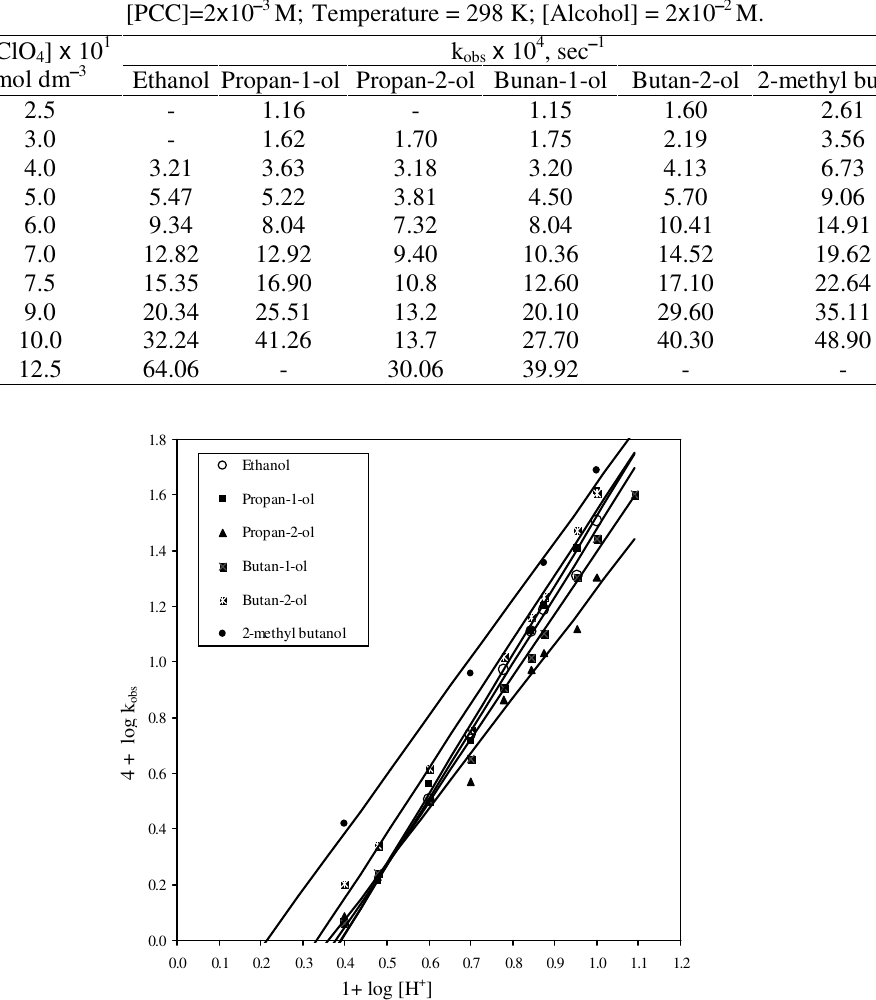
Table 2. Variation of rate with perchloric acid concentration